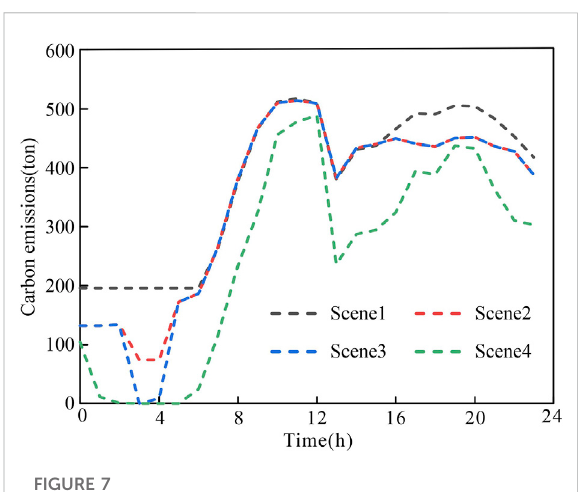
FIGURE 8 System cost and carbon emission under different storage tank